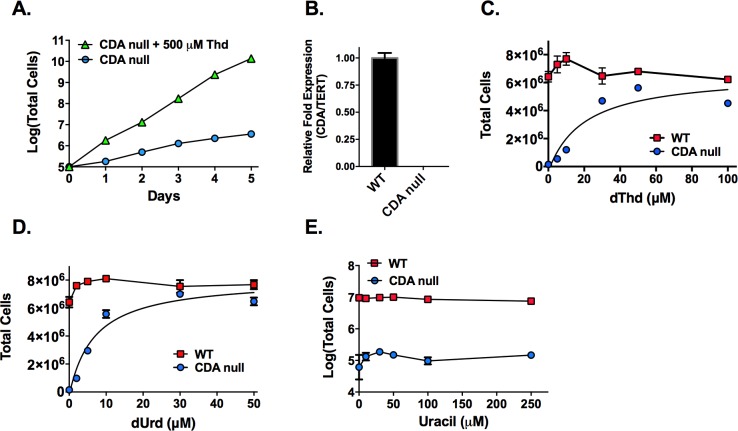
Deletion of the T. brucei CDA gene induces pyrimidine auxotrophy.A. Growth curves for CDA null cells grown in HMI-19 or HMI-19 media supplemented with 500 μM dThd. Cell growth was monitored for the indicated days. Error bars represent SD for triplicate biological replicates. B. qPCR analysis of CDA expression in wild-type SM and CDA null cells. Error bars represent SEM for triplicate data. C-E. Growth analysis of CDA null cells supplemented with dThd (C), dUrd (D) or uracil (E) over a range of concentrations 48 h post dThd withdrawl. Error bars represent the range for duplicate biological replicates. dThd and dUrd dose response curves were fitted to the Agonist vs response (three parameters) equation in GraphPad Prism (line represents the fit), to obtain ED50 for growth stimulation. ED50 = 20 μM (2.9–61) for dThd and 6.8 μM (3.8–13) for dUrd, where values in parenthesis represent the 95% confidence interval.